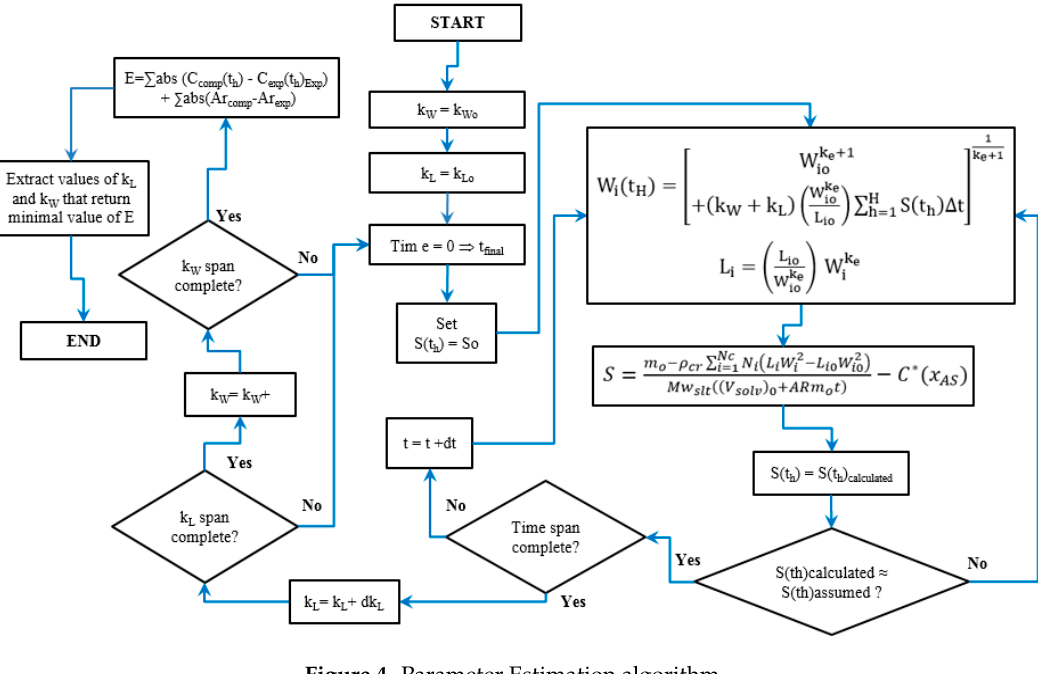
Figure 4. Parameter Estimation algorithm.